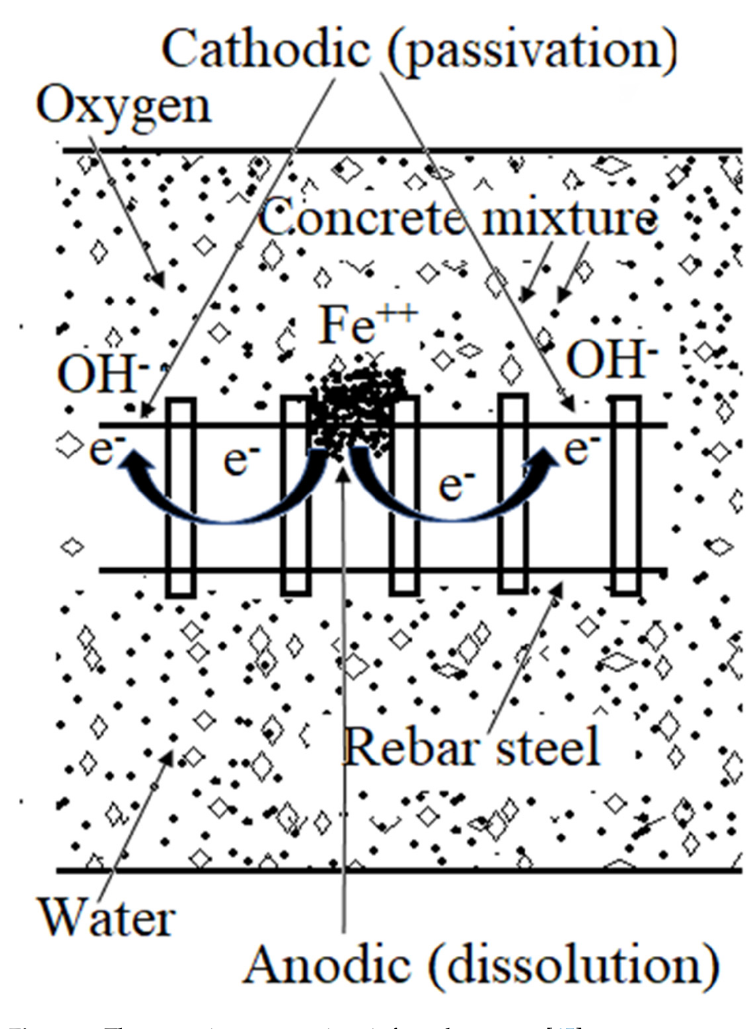
Figure 3. The corrosion process in reinforced concrete [45].